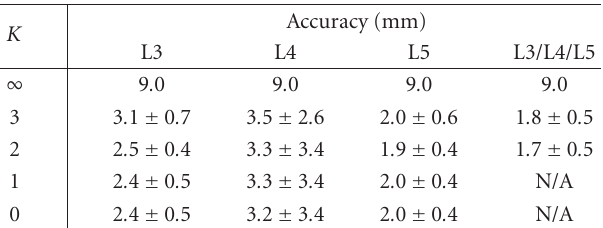
Table 2: Accuracy of the registration of the CT volume to eighteen pairs of C-arm images, at each level K of a multiresolution pyramid ( K = ∞ : initial condition). The angle between image planes is larger than 15 ◦ . The results for a single vertebra can be compared to those for joint vertebrae (L3/L4/L5).